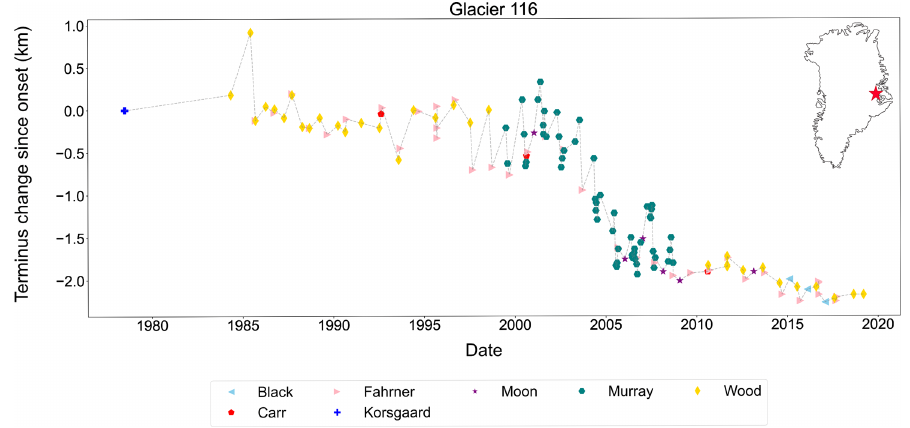
Figure 13. Example terminus change for Glacier 116 (F. Graae Gletscher). Color and symbol correspond to different authors for each